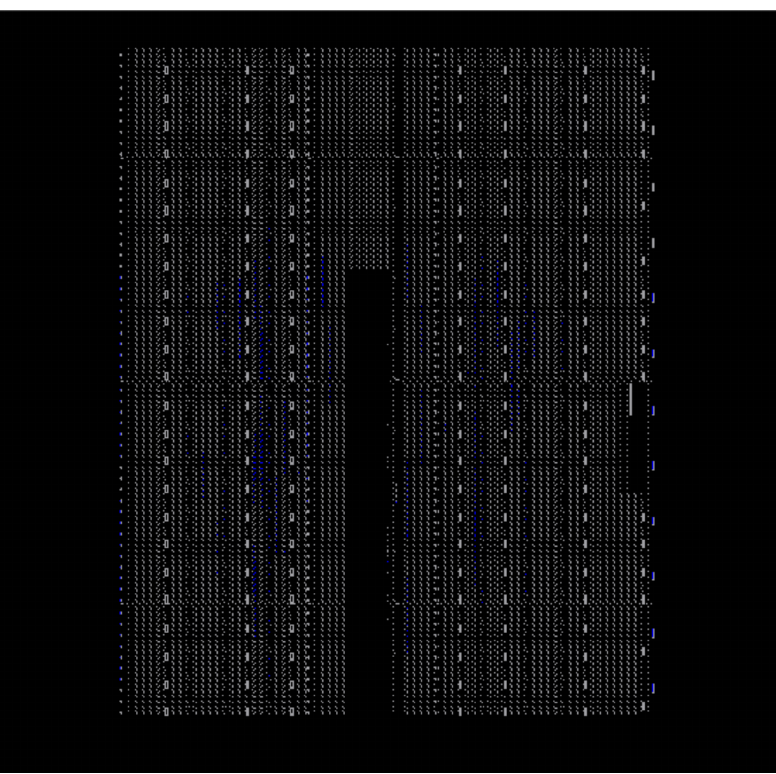
Figure 23. FPGA mapping of the first test case simulator.